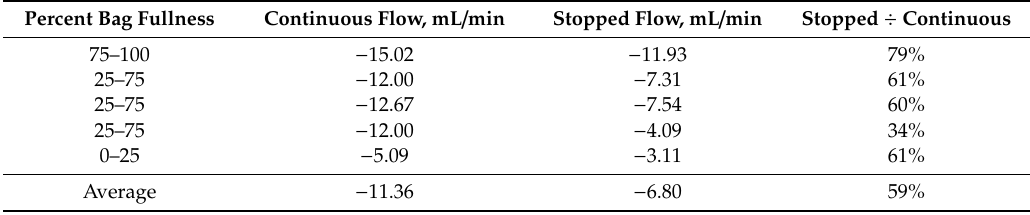
Table 2. Seepage bag results, in ml / min, during uninterrupted (Continuous flow) and during standard all